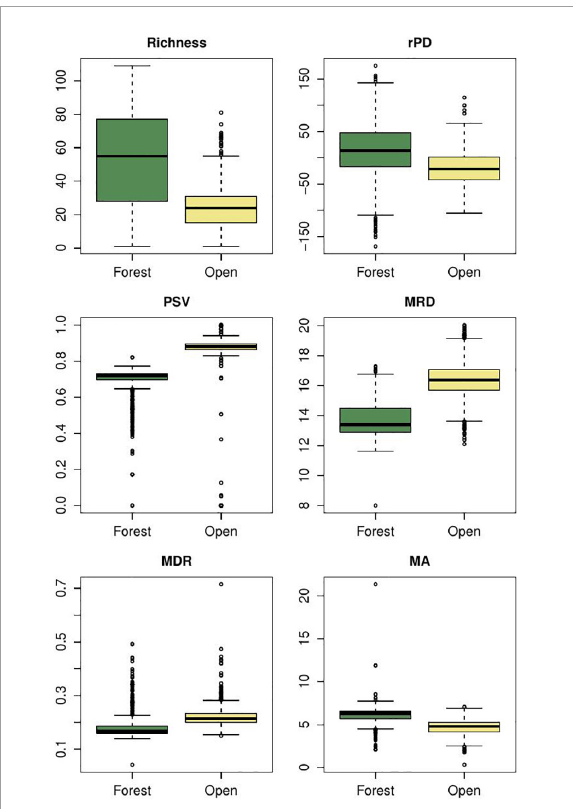
FIGURE3 Variation of phylogenetic metric values in Furnariides birds for forested and open areas. rPD, residual phylogenetic diversity (i.e., after controlling for species richness); PSV, phylogenetic species variability; MRD, mean root distance; mDR, mean diversification rate; mAges, average ages of species. Y-labels correspond to the values of each metric. Comparisons of metrics between regions were evaluated using Bayesian ANOVAs and all differences were significant (Maximum A posteriori p -values < 0.001).